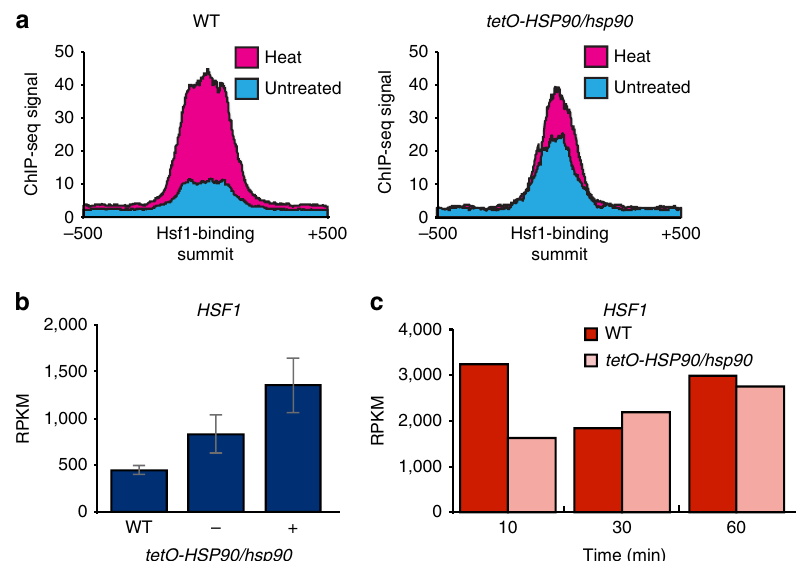
Figure 6 | Hsp90 modulates expression of HSF1 . ( a ) Depletion of HSP90 increases the binding signal of Hsf1 in the absence of heat shock compared with the wild type. Blue represents untreated, red represents heat shocked cells. ( b ) Expression of HSF1 , measured by RNA-seq, increases upon HSP90 depletion in the absence of heat shock. HSF1 expression in wild-type (SN95, WT) or tetO-HSP90/hsp90 D strain in the absence ( (cid:2) ) or presence ( þ ) of 20 m gml (cid:2) 1 doxycycline to repress HSP90 expression. Data represent mean values ± s.d. from three independent biological replicates ( c ) Heat induction of HSF1 expression in wild-type (dark red) versus tetO-HSP90/hsp90 D (light red) cells over a 10, 30 or 60min 30–42 (cid:2) C heat shock.